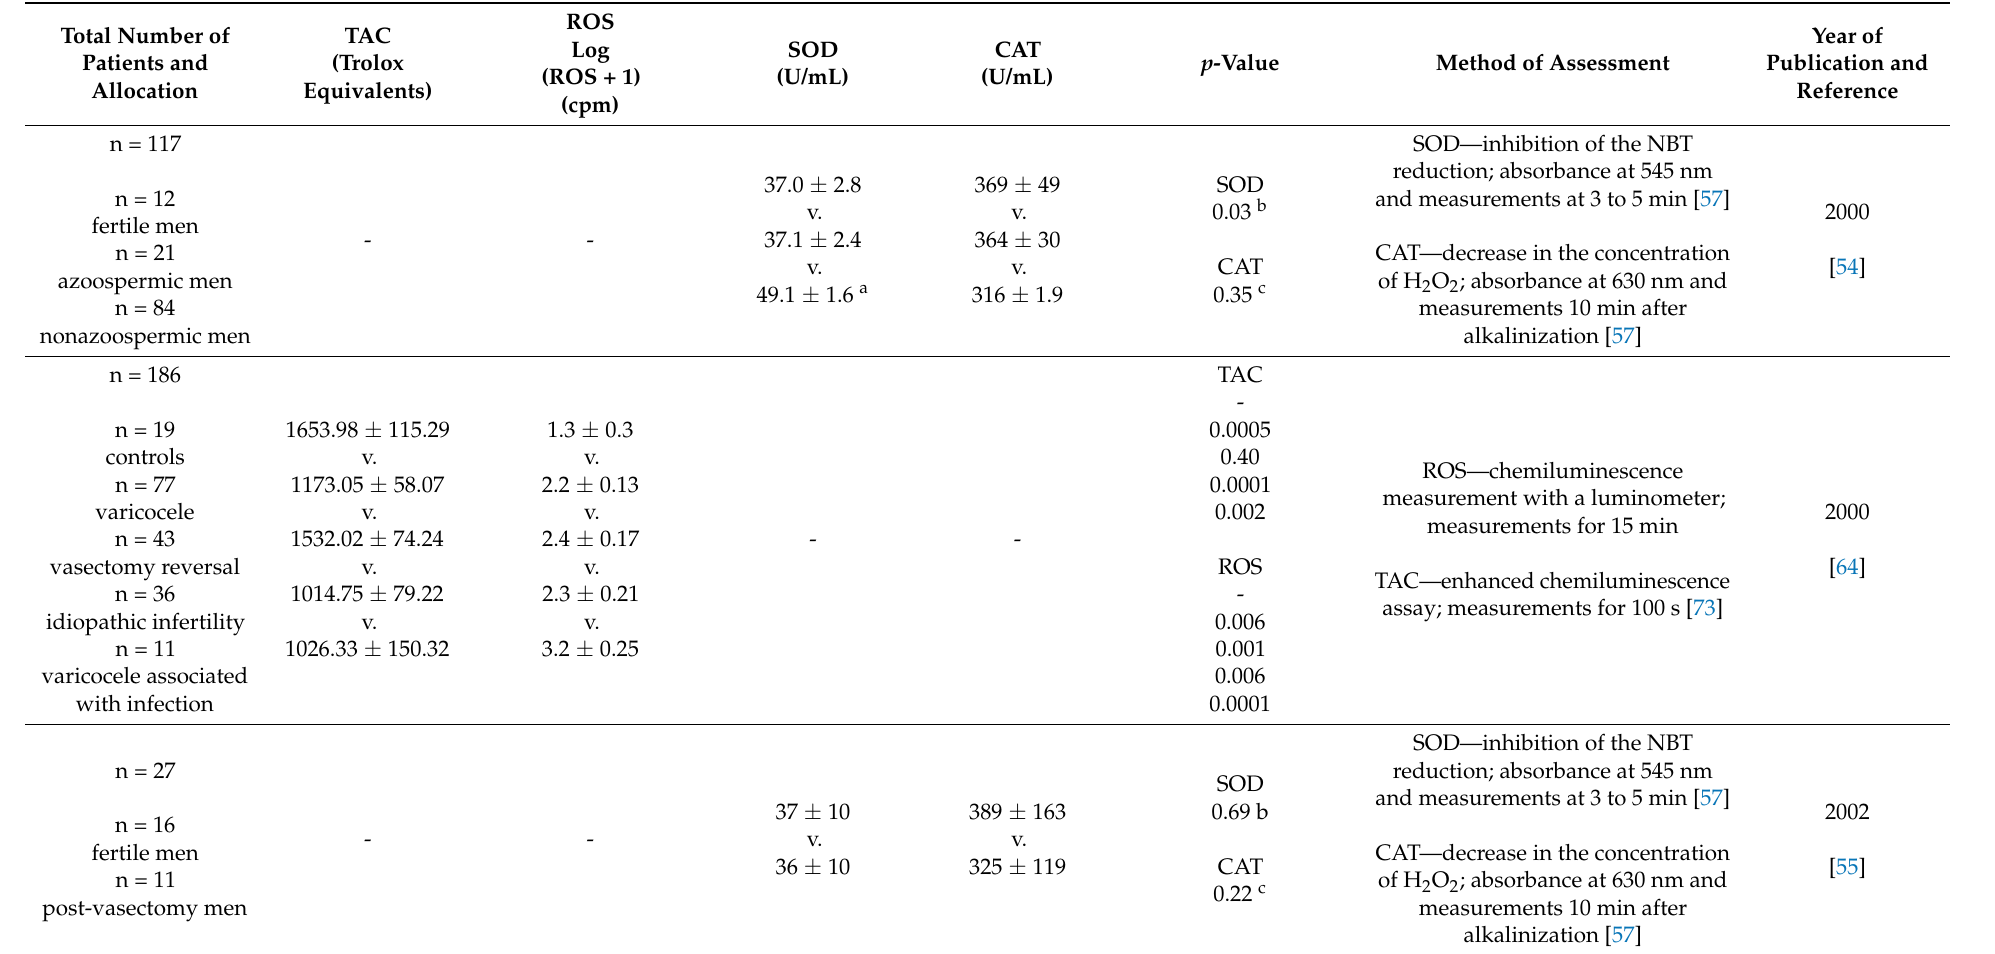
Table 1. Stratification of studies per year of publication based on design and allocation of patients with the main results that highlight changes in OS biomarkers in human